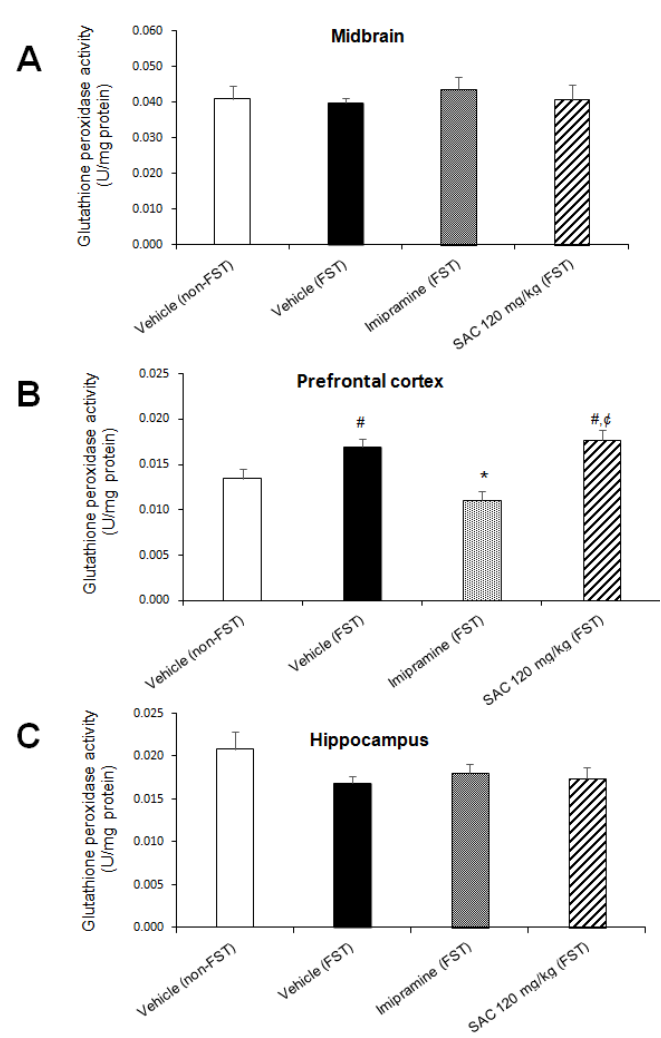
Figure 8. Effect of SAC on GPx activity in different brain regions in mice subjected to FST. The vehicle (non-FST or FST), imipramine (FST) or SAC (120 mg/kg) were the treatment groups. SAC did not change GPx activity in the midbrain ( A ), prefrontal cortex ( B ), or hippocampus ( C ) in FST vs. vehicle-FST group. Results are expressed as mean ± SEM of 7 – 9 animals per group. The one-way ANOVA followed by post hoc Duncan’s tests was used to analyze the differences among groups. (#) statistically different from vehicle non-FST group, p < 0.05, Duncan’s test; (*) statistically different from vehicle-FST group, p < 0.05, Duncan’s test; (¢) statistically different from imipramine (FST) group, p < 0.05, Duncan’s test. FST = forced swimming test; SAC = S -allyl cysteine; GPx = glutathione peroxidase. No changes were found in GR activity (Figure 9) in MB (F (3, 28) = 2.688; p = 0.066, PFC (F (3, 25) = 0.942; p = 0.435) and HP (F (3, 29) = 0.374; p =